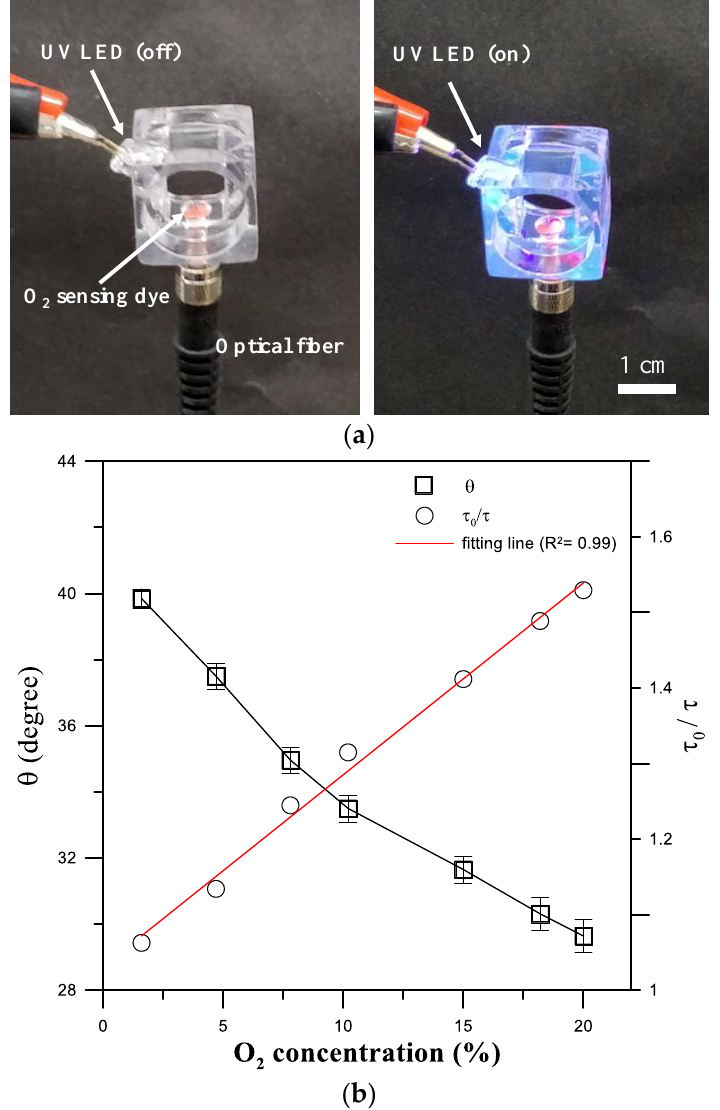
Figure 4. ( a ) A fiber-optic oxygen sensing section with a 1 mm diameter microwell coated with an oxygen-sensitive layer and excited by a UV LED modulated at 5 kHz to measure the luminescent phosphorescence lifetime of the oxygen-sensitive layer to quantify O 2 concentrations. ( b ) Phase shift ( θ ) and normalized lifetime ( τ 0 / τ ) as a function of the dissolved oxygen (DO) concentration. (Mean ± SEM; n = 5).